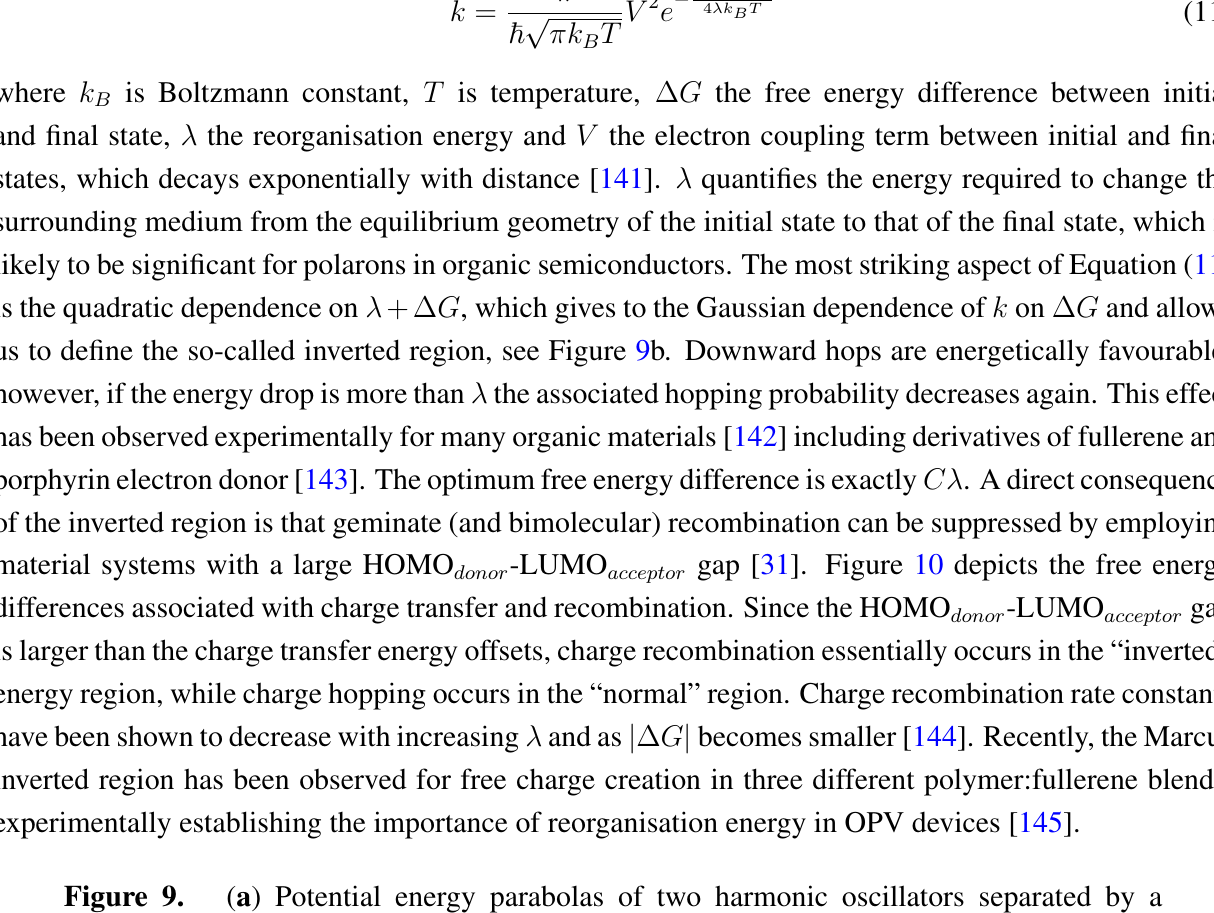
( a ) Potential energy parabolas of two harmonic oscillators separated by a distance r ; ( b ) normalised Marcus transfer rate as a function of the free energy